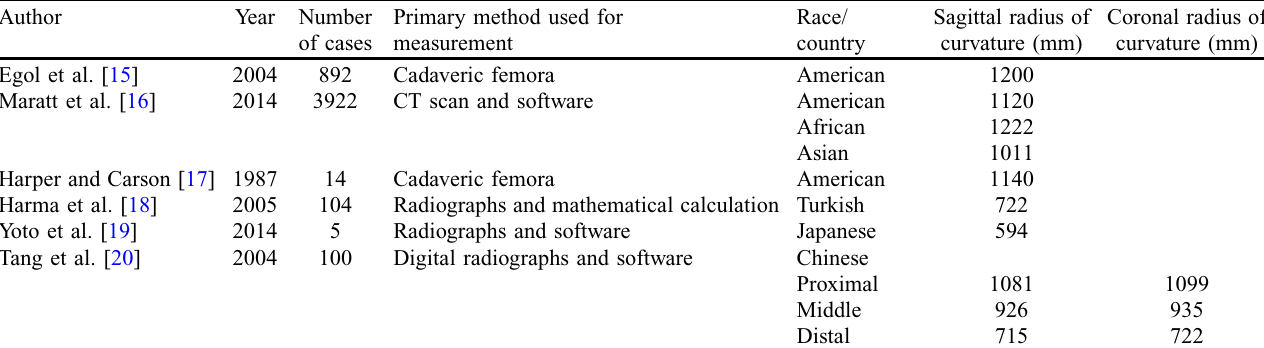
Table 2. Summarizing the results of currently available studies in the literature about femoral curvatures in different